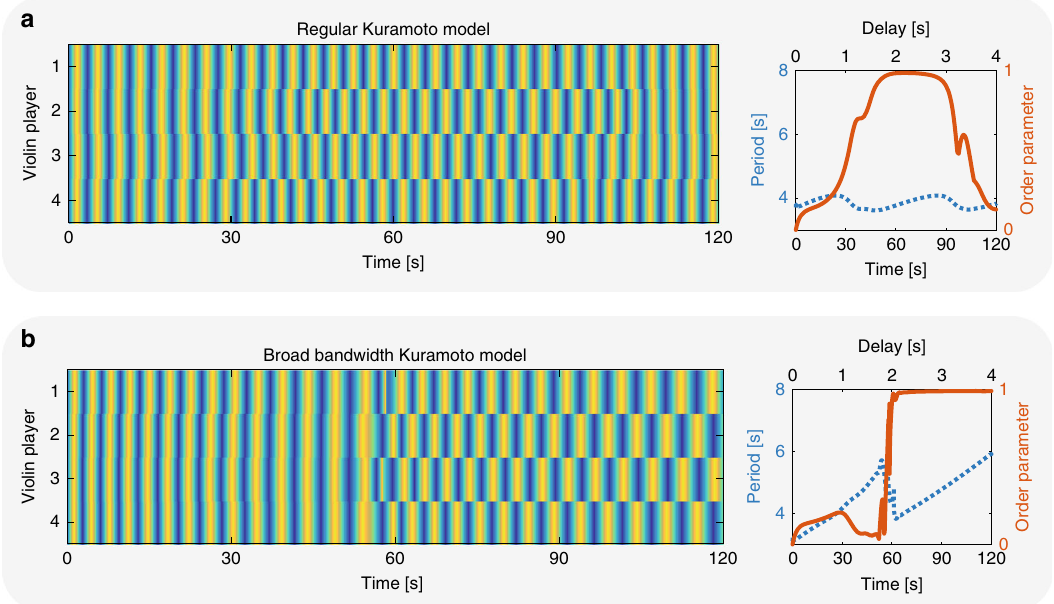
Fig. 8 Calculated results of four coupled violin players. a Calculated results of the regular Kuramoto model for four coupled players. In this model, the players cannot maintain the out-of-phase state of synchronization when the delay increases. b Calculated results of the broad-bandwidth Kuramoto model for four coupled players. In this model, the players change their playing period to maintain the out-of-phase state of